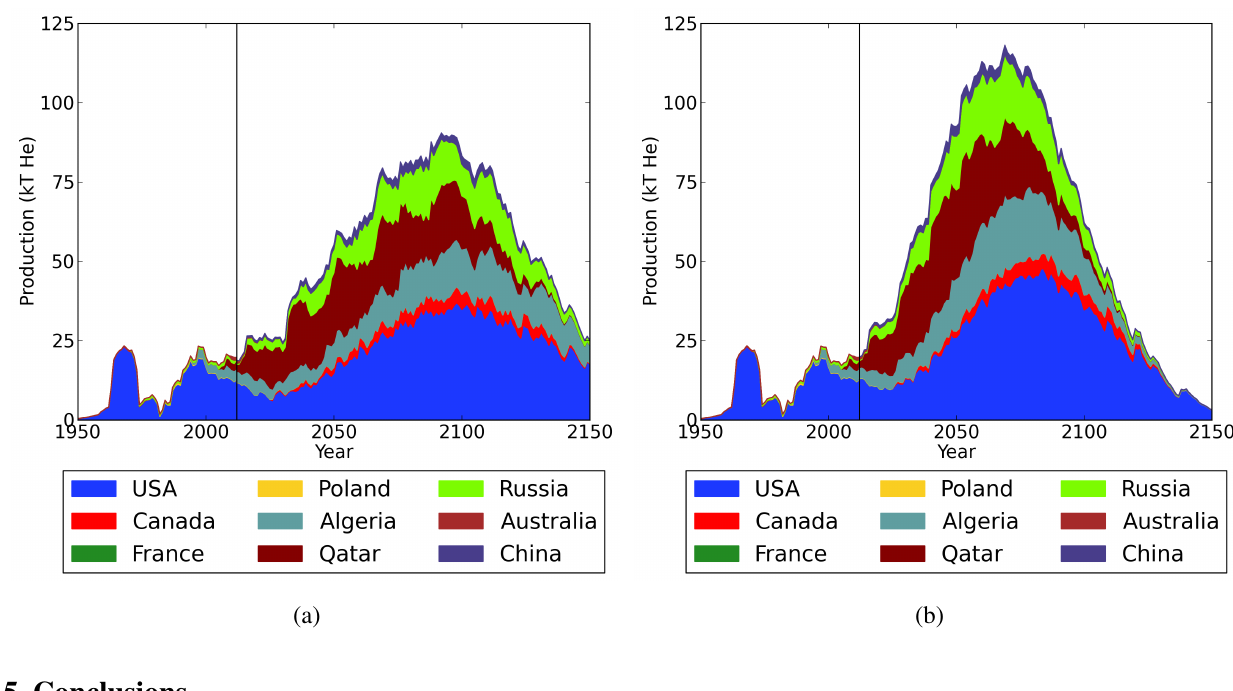
Figure 5. Projection of helium production for the world by country: ( a ) regular growth and ( b ) low weigh